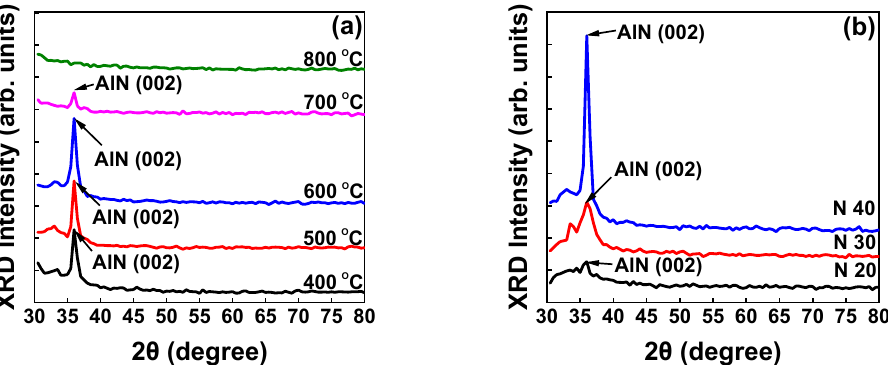
Figure 2. ( a ) XRD pattern of AlN (002) deposited at temperatures ranging from 400 to 800 ◦ C, ( b ) XRD pattern of AlN (002) deposited by varying the nitrogen flow rate from 20 to 40 sccm.